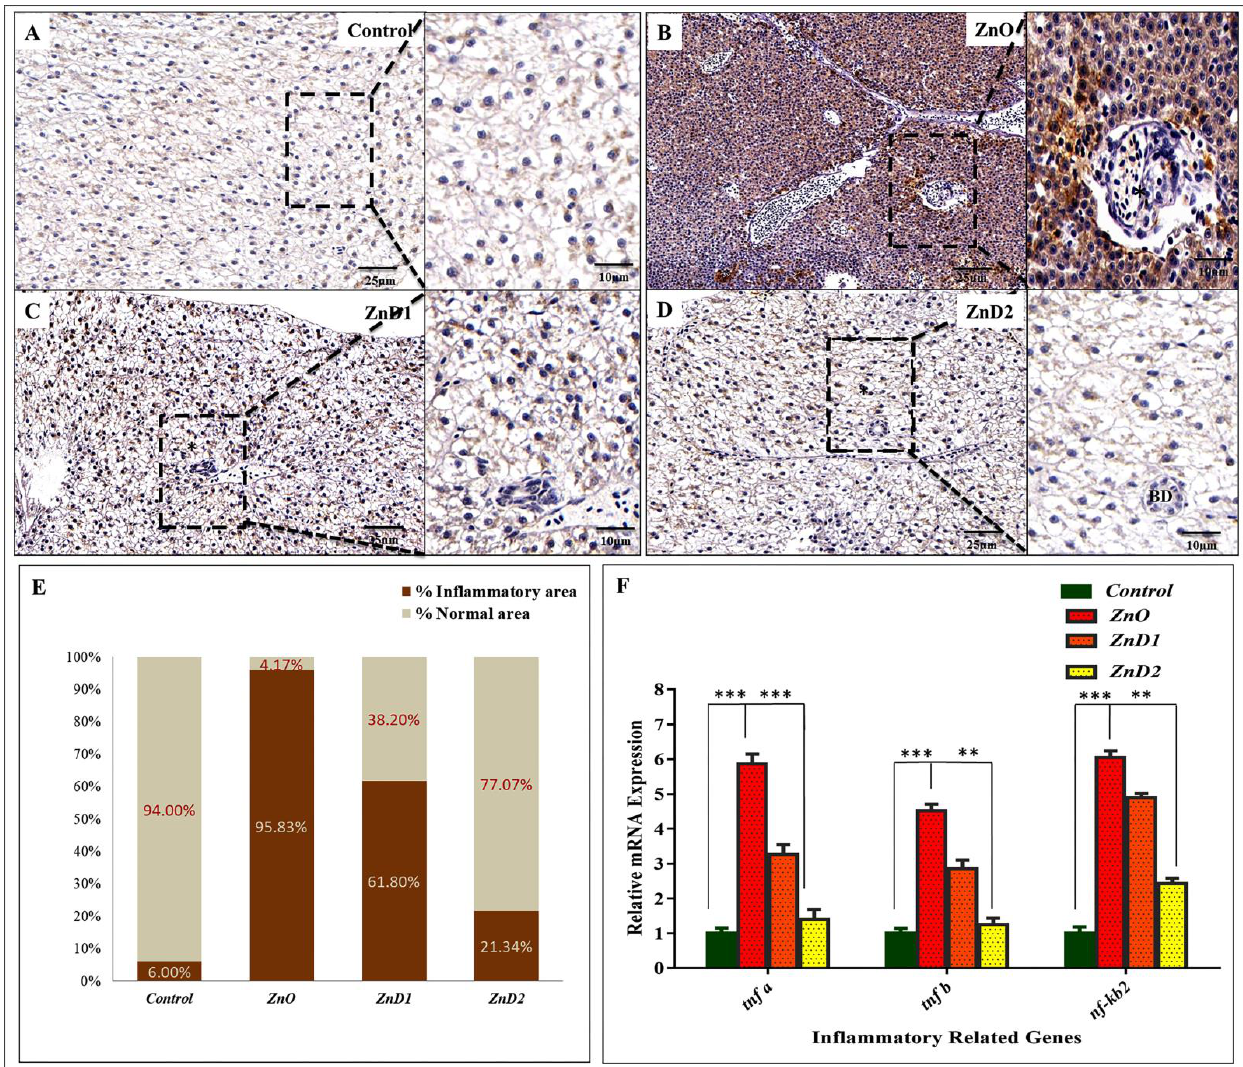
Figure 7. The ameliorative effect of D. salina on the liver inflammation induced by ZnO-NPs: ( A , B ) Representative photomicrographs of TNF- α immunohistochemistry of liver sections in the control and ZnO-NPs groups showing no positive reaction for TNF- α in the hepatocytes of the control group compared with the ZnO-NPs group; ( C , D ) representative photomicrographs of ZnD1, and ZnD2 groups showing weak expression of TNF- α (The brown color indicating TNF- α positively); ( E ) the mean cell number per unit area was quantified by NIH Image J. The results were normalized from three independent sections of the same area; ( F ) mRNA expression of genes involved in the (NF- κ B) inflammatory signaling pathway. Scale magnifications were shown in pictures and data expressed as means ± SD. * p < 0.05 (significant), ** p < 0.01 (highly significant), *** p < 0.001 (very high